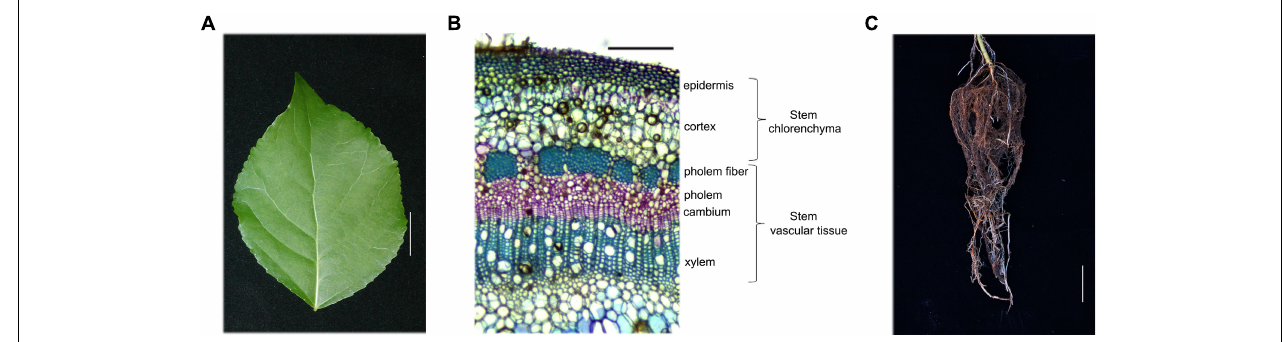
FIGURE 1 | Hybrid poplar tissue and cell types used in this study. (A–C) Tissues collected from 5-month-old P. simonii × P. nigra grown in a greenhouse. (A) Leaf morphology. Scale bar, 2 cm. (B) Cross-section of a stem stained with toluidine blue. The cell types are labeled on the right. Many chloroplasts can be seen in the epidermis and cortex cells, which are called the stem chlorenchyma in our study. Phloem fiber, phloem, cambium and xylem cells are called stem vascular tissue. Scale bar, 200 µ m. (C) Root morphology. Scale bar, 5